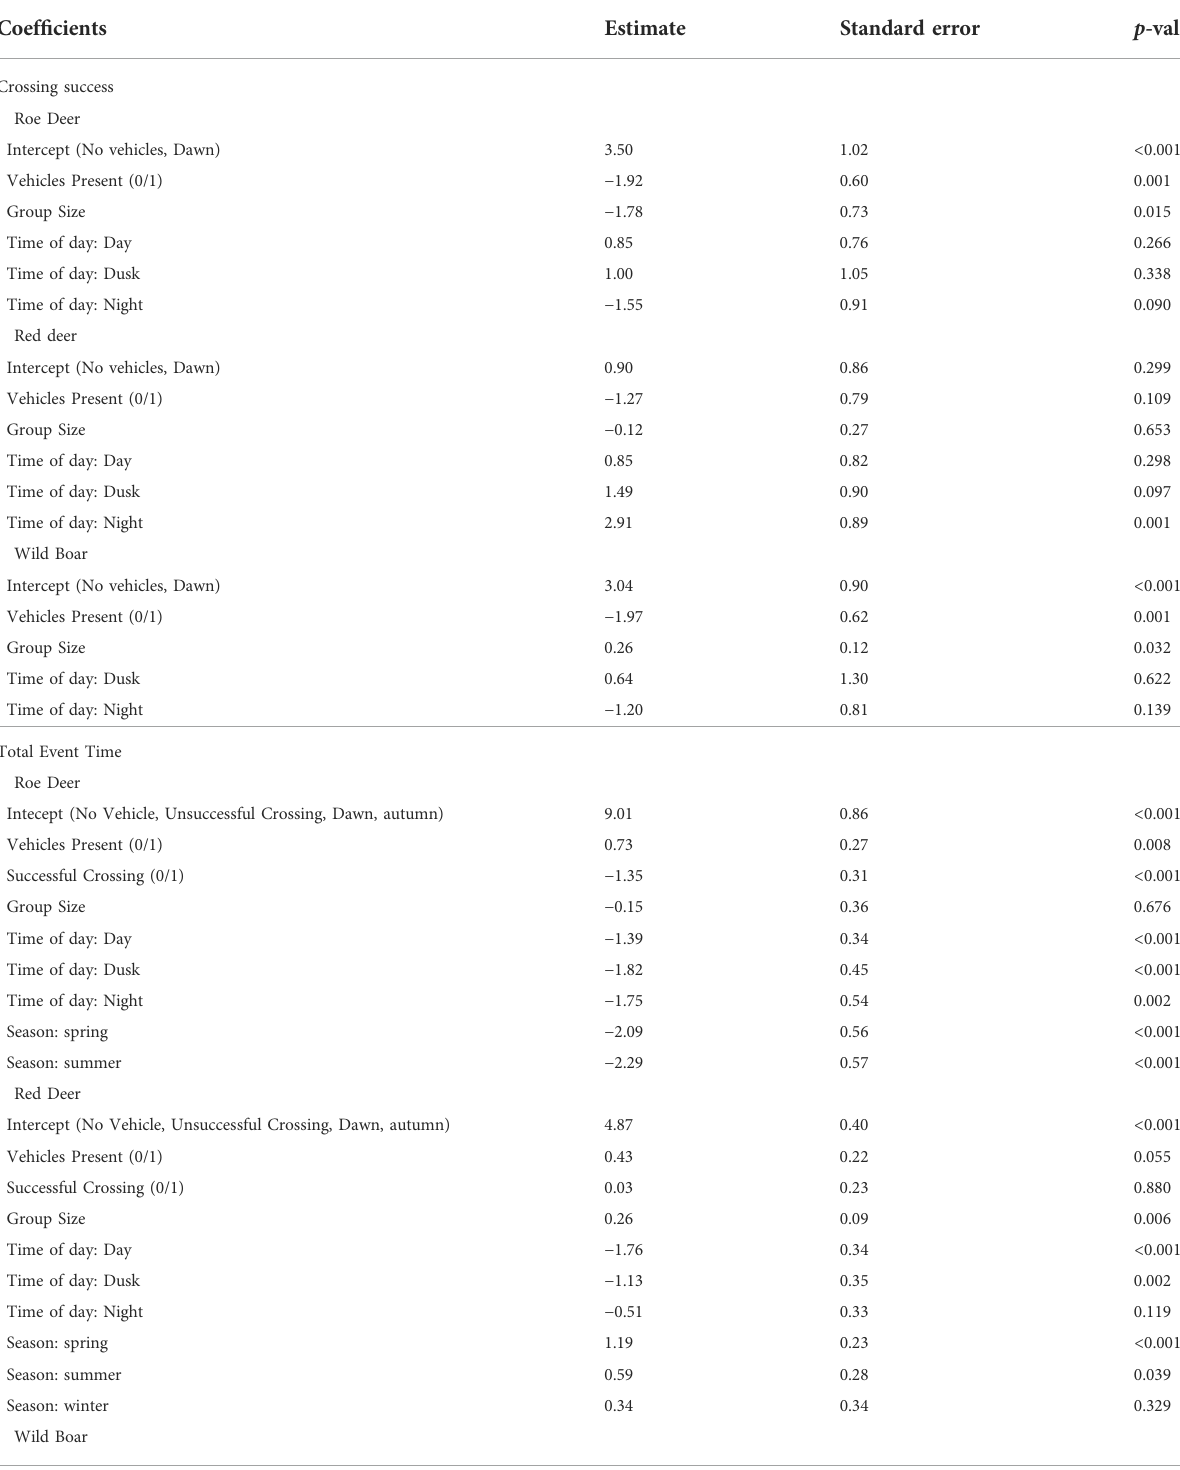
TABLE 2 Model outputs for roe deer, red deer and wild boar. Crossing success was estimated using a binomial regression, in relation to the presence of a vehicle during the event, the group size, and the time of day. A crossing was only considered successful if all individuals of the group crossed theroad(i.e.,withoutturningback,orbeinginvolvedinacollision).Totaltimeofanevent,thetimetheindividual/groupspentontheroadsideverge, and the time the individual/group spent on the roads were estimated using gamma regressions (with a log link) to explore the in fl uence of vehicle presence, crossing success, group size, time of day and season on the time spent. In each model, the reference time of day was dawn, and the reference season was autumn. Roe deer, red deer and wild boar were modelled